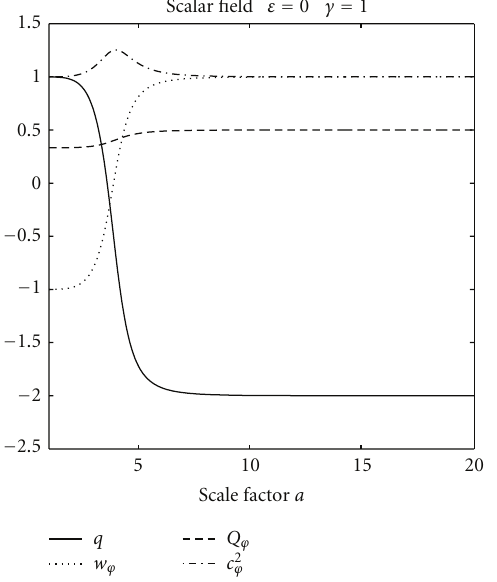
Figure 4: Evolution of the acceleration parameter q = +¨ aa/ ˙ a 2 ver- sus the scale factor, for γ = 1. Also shown in the graph: the evolution of the scalar field EoS w ϕ and Q ϕ and c 2 superluminal during the transition from a de Sitter Universe to a to sti ff matter-dominated one. However, as discussed in the text, it remains hyperbolic and, thus, causal. Moreover, it carries positive energy.